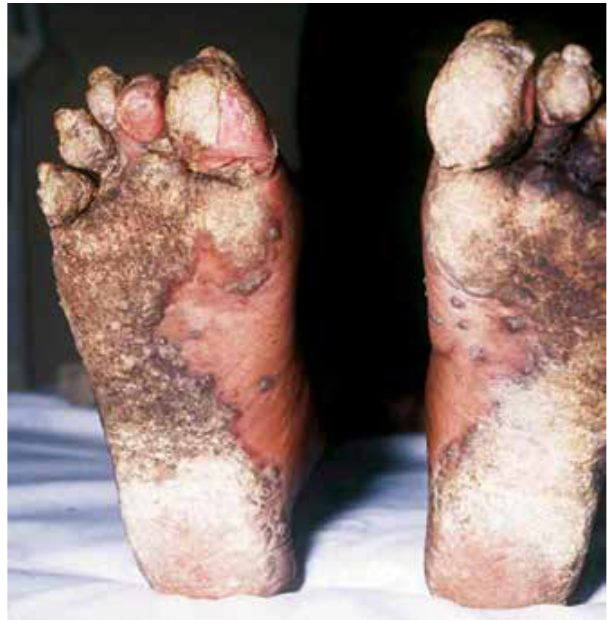
Figure 3: Keratoderma blenorrhagicum in a patient with Reiter’s syndrome